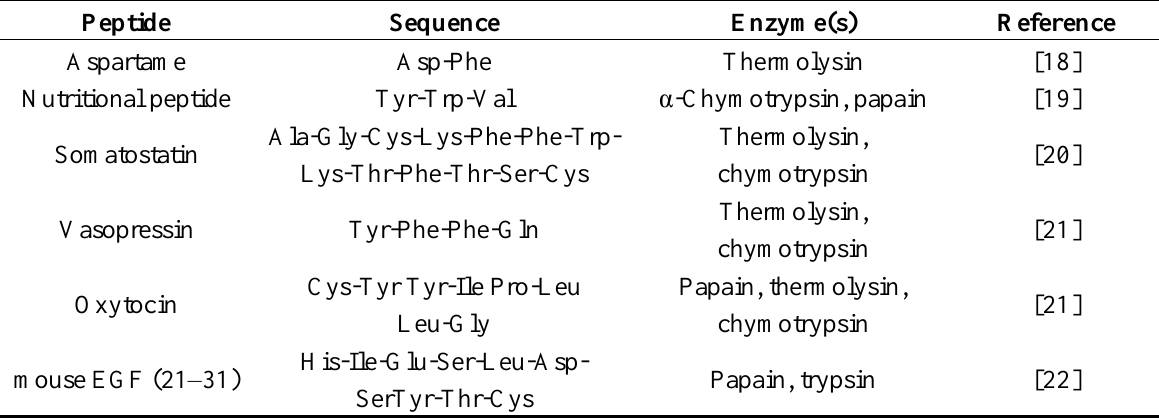
Table 2. Examples of peptides synthesized by